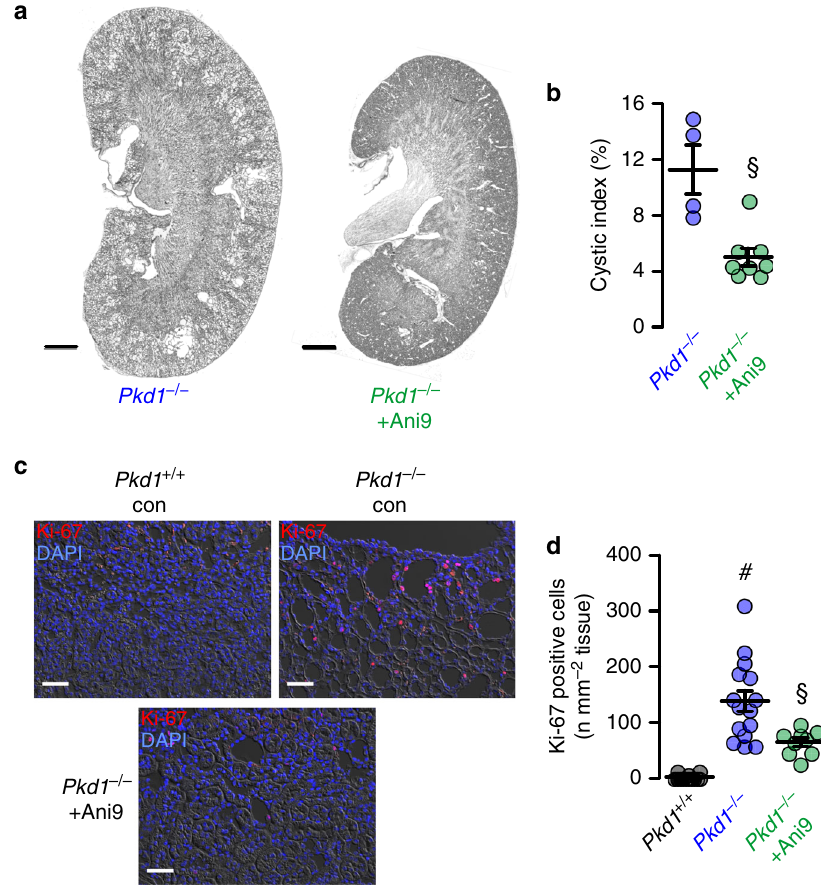
Fig. 8 Ani9 inhibits polycystic kidney disease in a mouse model for ADPKD. a Representative images of kidneys from induced ( Pkd1 − / − ) mice, untreated (daily i.p. injection of corn oil) ( n = 8 kidneys analyzed from n = 4 animals) or treated with Ani9 in corn oil (Ani9, 0.5 mg/kg/day, i.p.) for 30 days ( n = 8 kidneys analyzed from n = 4 animals). Scale bars 1000 µ m. b Cystic index (%) 8 weeks after induction of Pkd1 + / + and Pkd1 − / − mice, untreated or treated with Ani9. Ani9 reduced cyst growth in Pkd1 − / − mice ( § P = 0.001). § Unpaired two-sided t test. c , d Proliferating cells identi fi ed in Pkd1 + / + and Pkd1 − / − kidneys by the proliferation marker ki-67 (red). Scale bars 50 µ m. Proliferation was upregulated in Pkd1 − / − mice ( # P < 0.0001), but was largely inhibited by Ani9 ( § P = 0.021). #§ One-way ANOVA and Tukey ’ s post-hoc test. Number of ki-67 positive cells was normalized to the tissue area. Mean and error bars indicating ±SEM (25 independent images from n = 8 kidneys of n = 4 animals each). Mean and error bars indicating ±SEM. Source data are provided as a Source Data fi